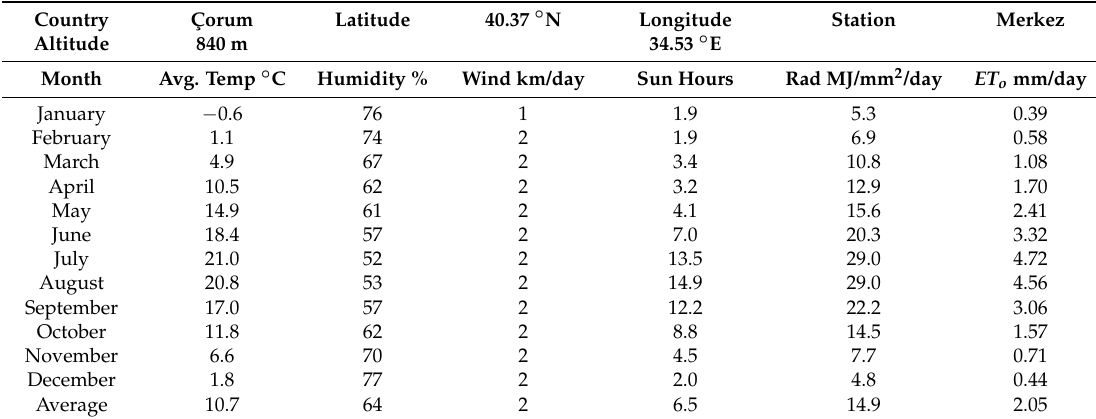
Table 1. Çorum/Center climate/ evapotranspiration ( ET o ) data.